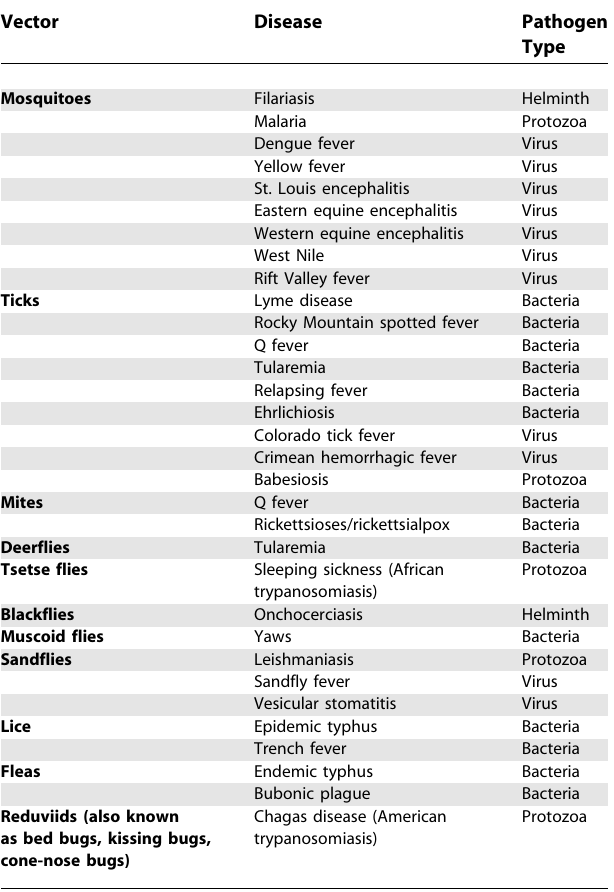
Table 1. Common Arthropod Vectors, Diseases, and the Type of Pathogen Responsible for the Disease Vector